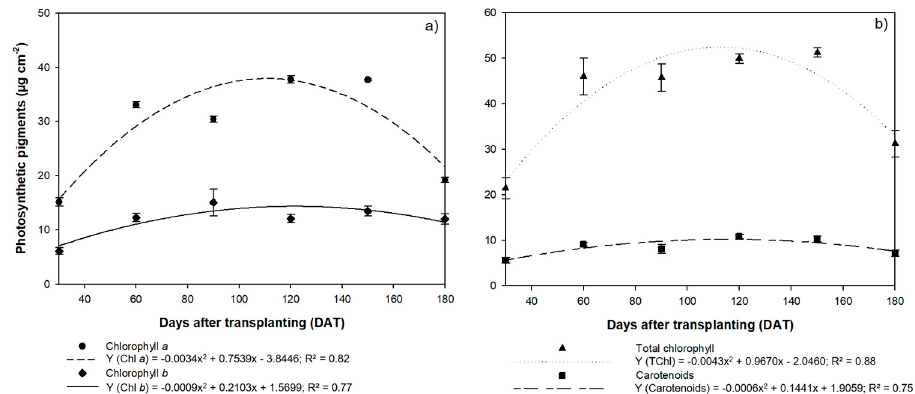
Figure 6. Mean concentrations of ( a ) chlorophyll a and b photosynthetic pigments and ( b ) total chlorophyll and carotenoids recorded in the leaves of the seedlings of Hymenaea courbaril L. cultivated in a hydroponic system and sampled at 30-day intervals across their initial development (30, 60, 90, 120, 150, and 180 days after transplantation). Marker bars = SE (Mean standard error - observed for eight repetitions).